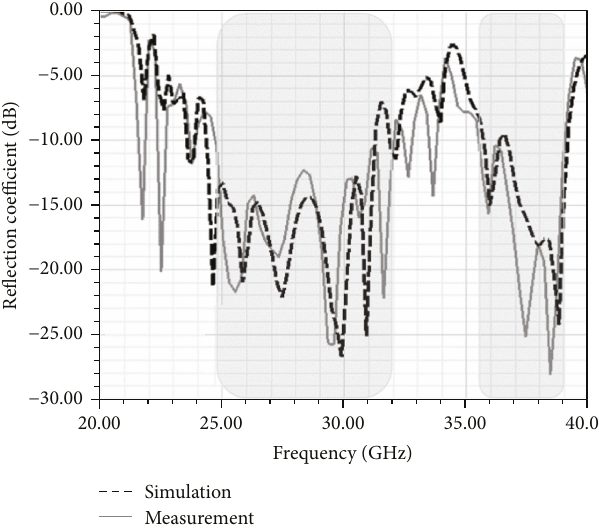
Figure 11: Re fl ection coe ffi cient of the proposed dual-band